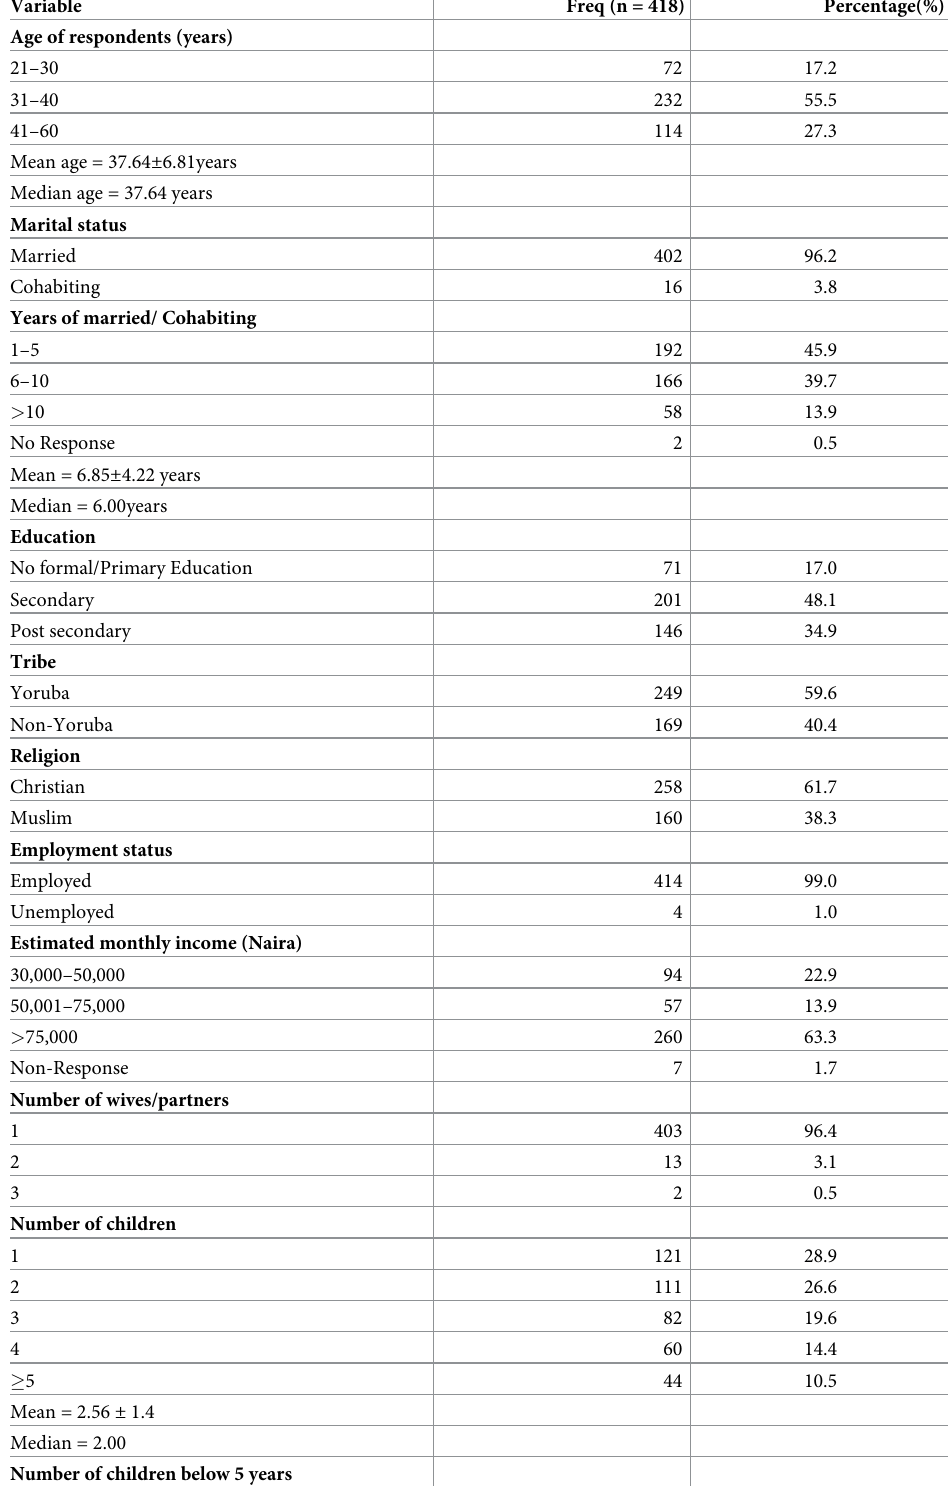
Table 1. Socio demographic characteristics of